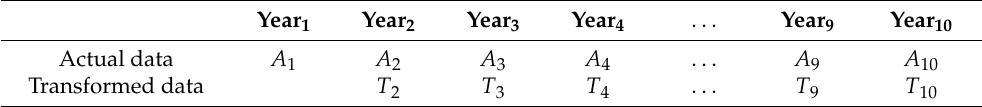
Table 1. An example of actual and transformed